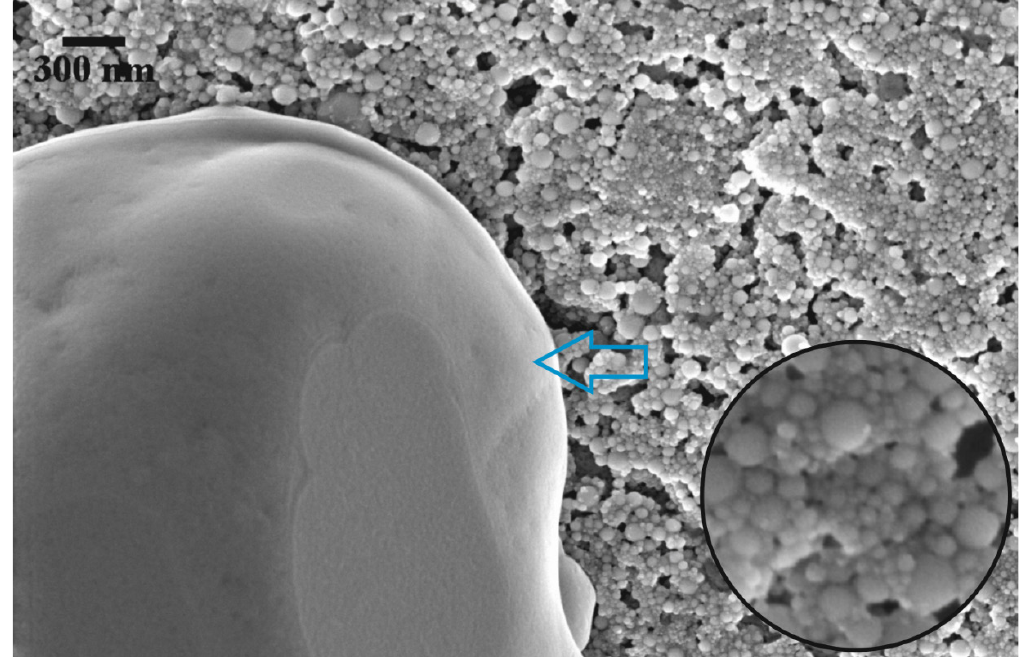
Figure 7. SEM image of 1.0 wt % TiO 2 (×75,000 magnification). The blue arrow points at the surface of molten salt free from nanoparticles. Bottom right side shows a magnified image of titanium dioxide